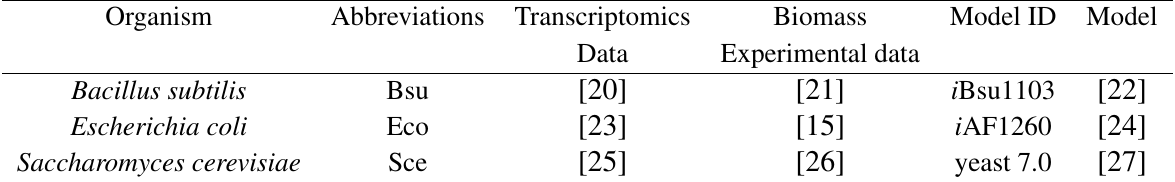
Table 1: Organisms data and models used to estimate biomass composition in amino acids and nucleotides and to perform